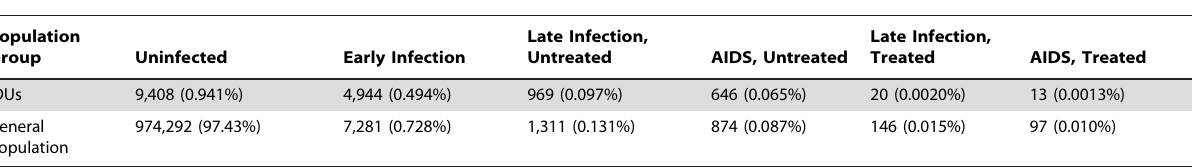
Table 3. Initial population distribution for the